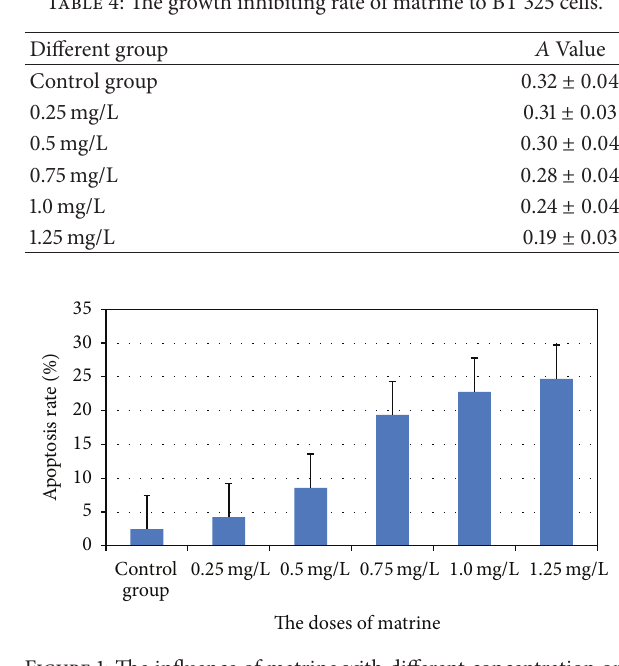
Figure 1: The influence of matrine with different concentration on apoptosis rate of BT 325